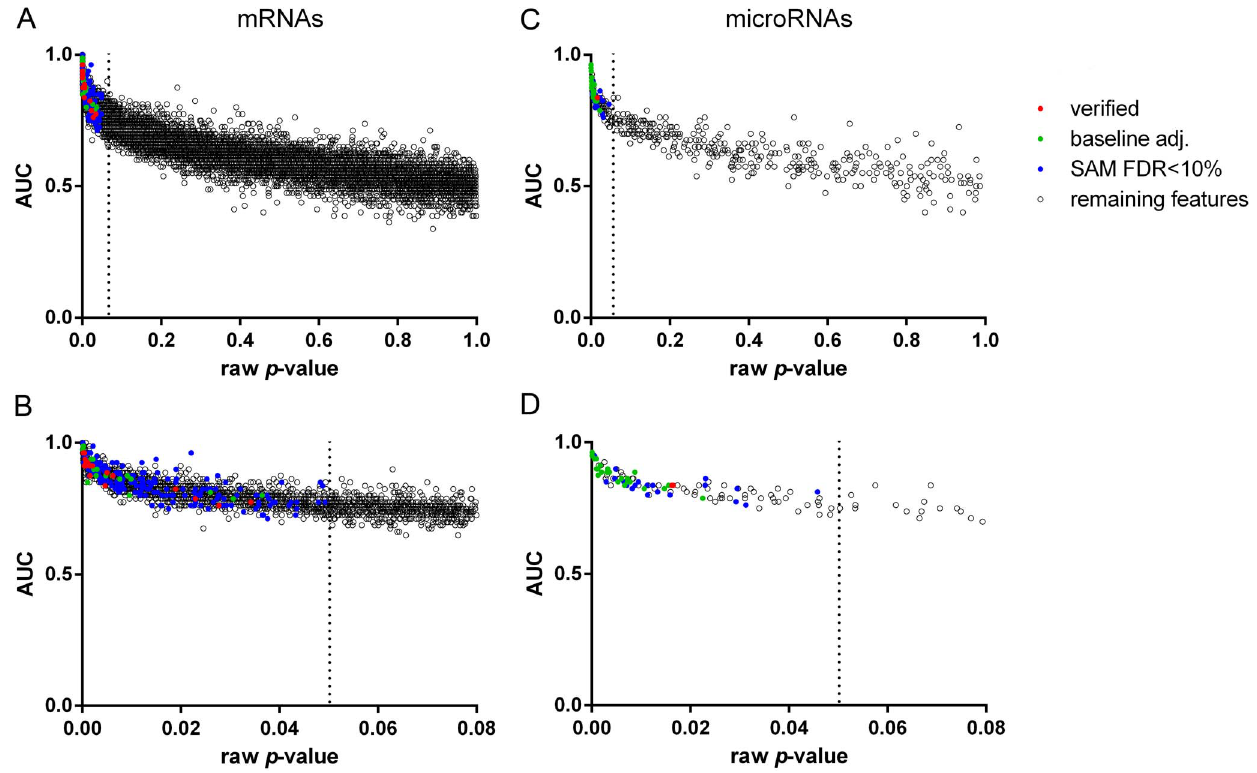
Figure 1. Raw p -values and area under the curve (AUC) of the investigated mRNAs and miRNAs comparing post-TX AKI and PGF allografts. (A) full p-value range of mRNAs (B) mRNAs with p -value , 0.08 on the x-axis for specific visualization of features with a raw p -value , 0.05 (C) full p-value range of microRNAs (D) microRNAs with raw p -value , 0.08 on the x-axis; red: features verified in an independent dataset (20 mRNAs and two microRNAs), green: significant features after baseline adjustment (39 mRNAs and 29 miRNAs), blue: significant features identified by SAM (245 mRNAs and 49 microRNAs), black: remaining features (11,788 mRNAs and 393 microRNAs).